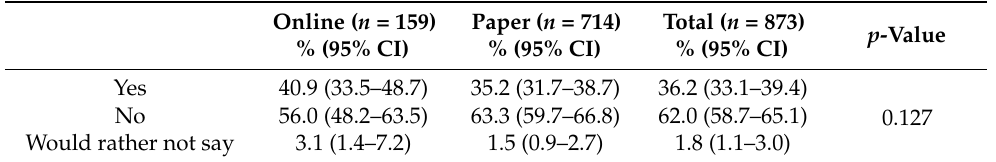
Table 2. Respondents who had family/wh¯anau member or close friend who consumed alcohol in a harmful way, by questionnaire